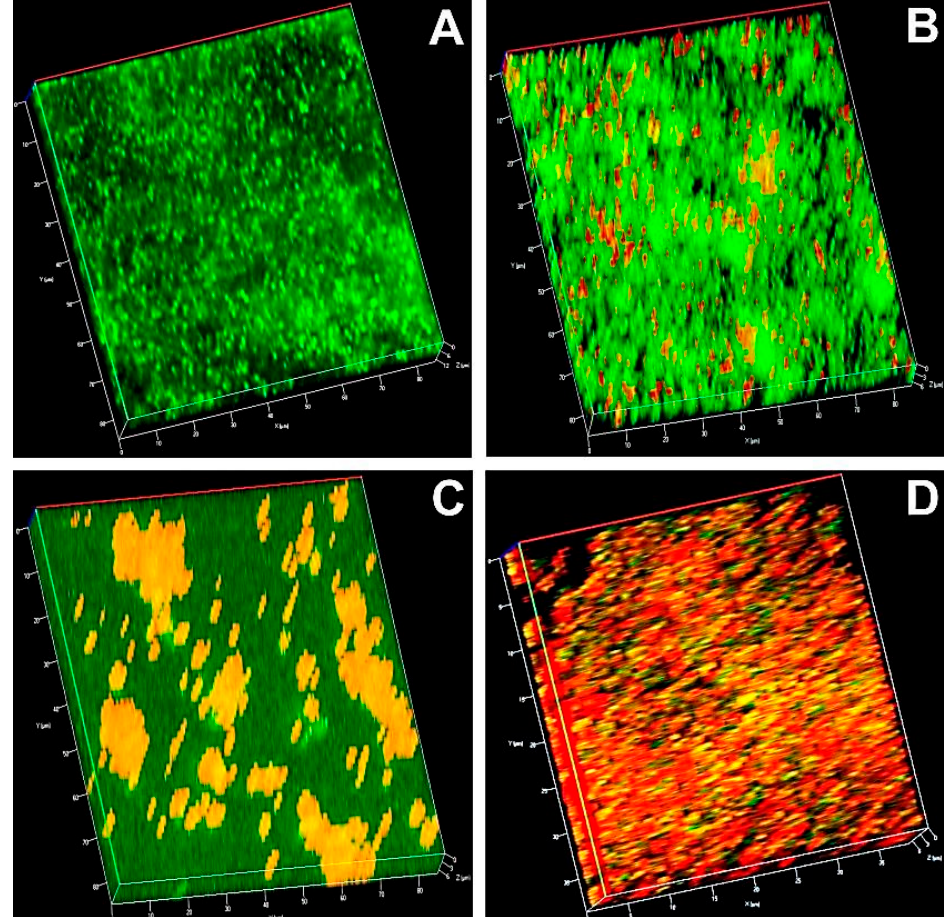
Figure 6. Confocal laser scanning microscopic image of S. aureus ( A ) irradiated biofilm (control); ( B ) biofilm treated with MB and irradiated; ( C ) biofilm treated with AgNPs and irradiated; ( D ) biofilm treated with MB-AgNPs and irradiated. Green represents live cells; Red represents dead cells in the